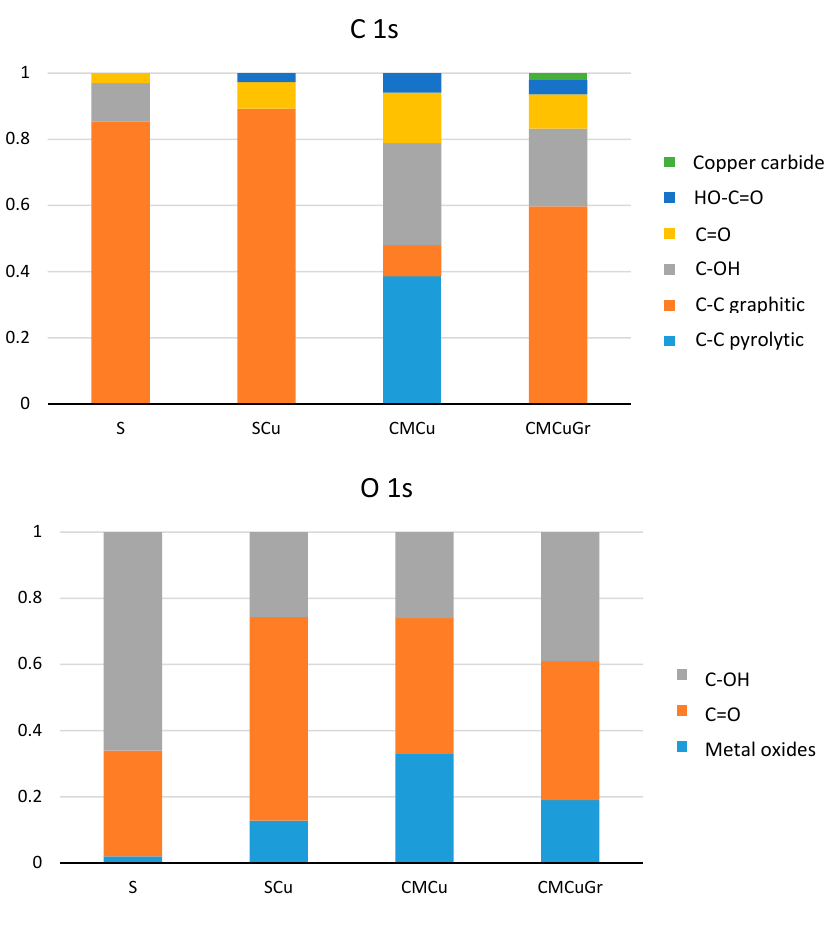
Figure 3. Relative distribution of surface functional groups identified by XPS.